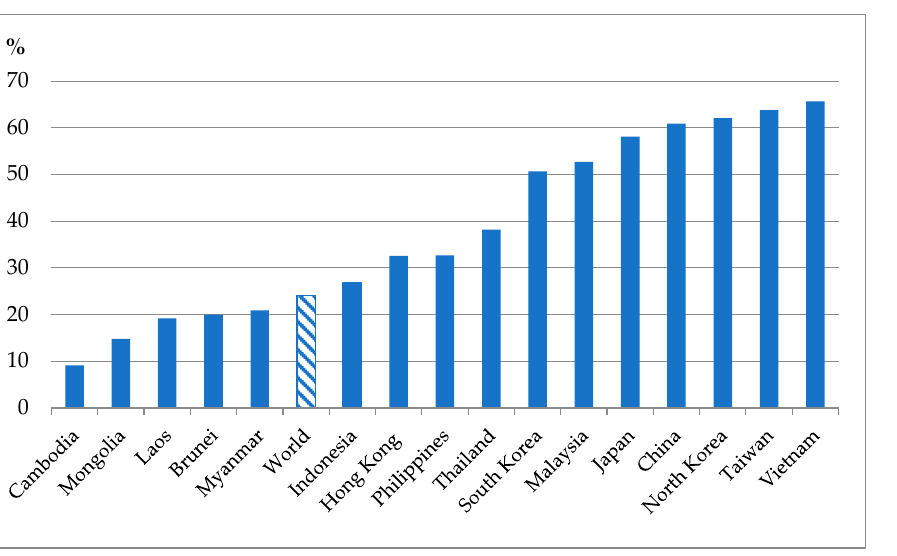
Figure 4. Percentage point change in cereal import dependency ratio in East and Southeast Asia (Source: data retrieved and adapted from [4]).